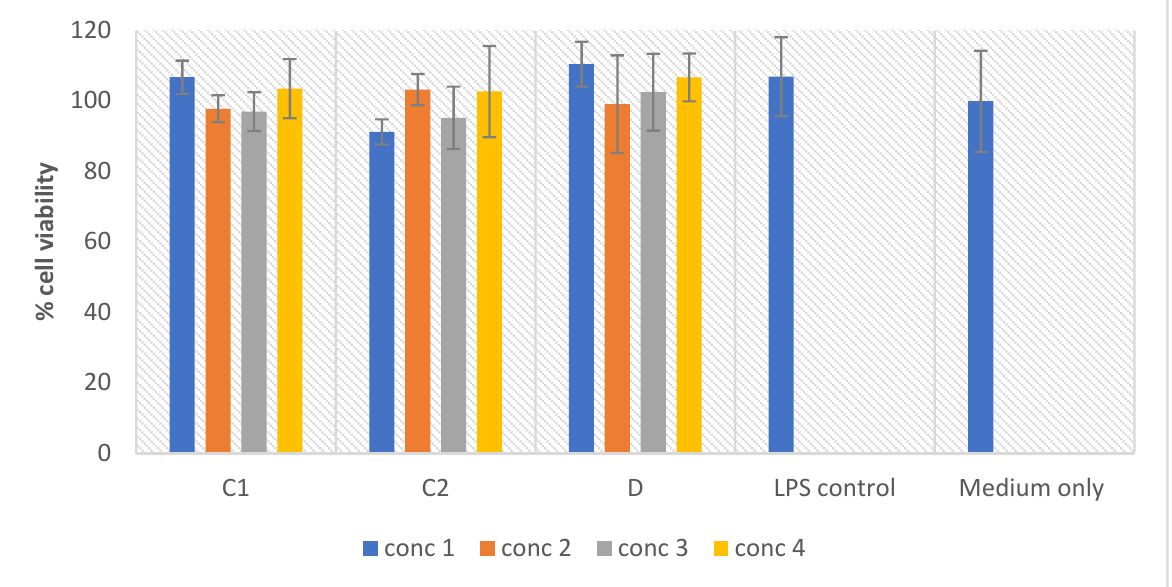
Figure 12. Cell viability (%) of the LPS activated macrophages after 24 h exposure to the treatments. Concentrations tested were as follows: Sample C1 (methanol extract): 5, 10, 20, and 40 μ g/mL; Sample C2 (chloroform extract): 1.25, 2.5, 5, and 10 μ g/mL. Bar graph represents the quadruplicate values of one experiment. Error bars represent the standard deviation of the mean.